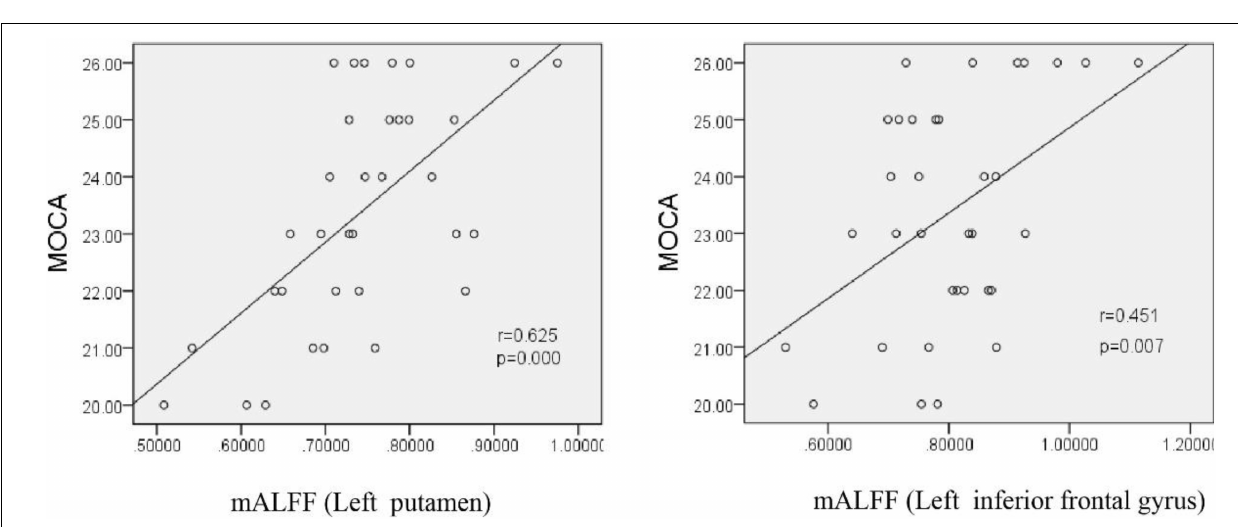
basis of the corpus callosum does not involve attention, but